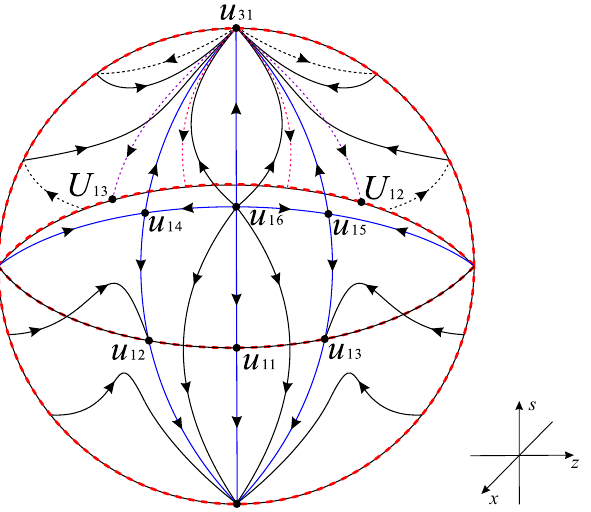
Fig. 7 The global phase portrait at infinity in the Poincaré sphere. The North Pole of the Poincaré ball is the equilibrium point u 31 . The symmetric points of u 12 and u 13 with respect to the center of the sphere are U 12 and U 13 , respectively